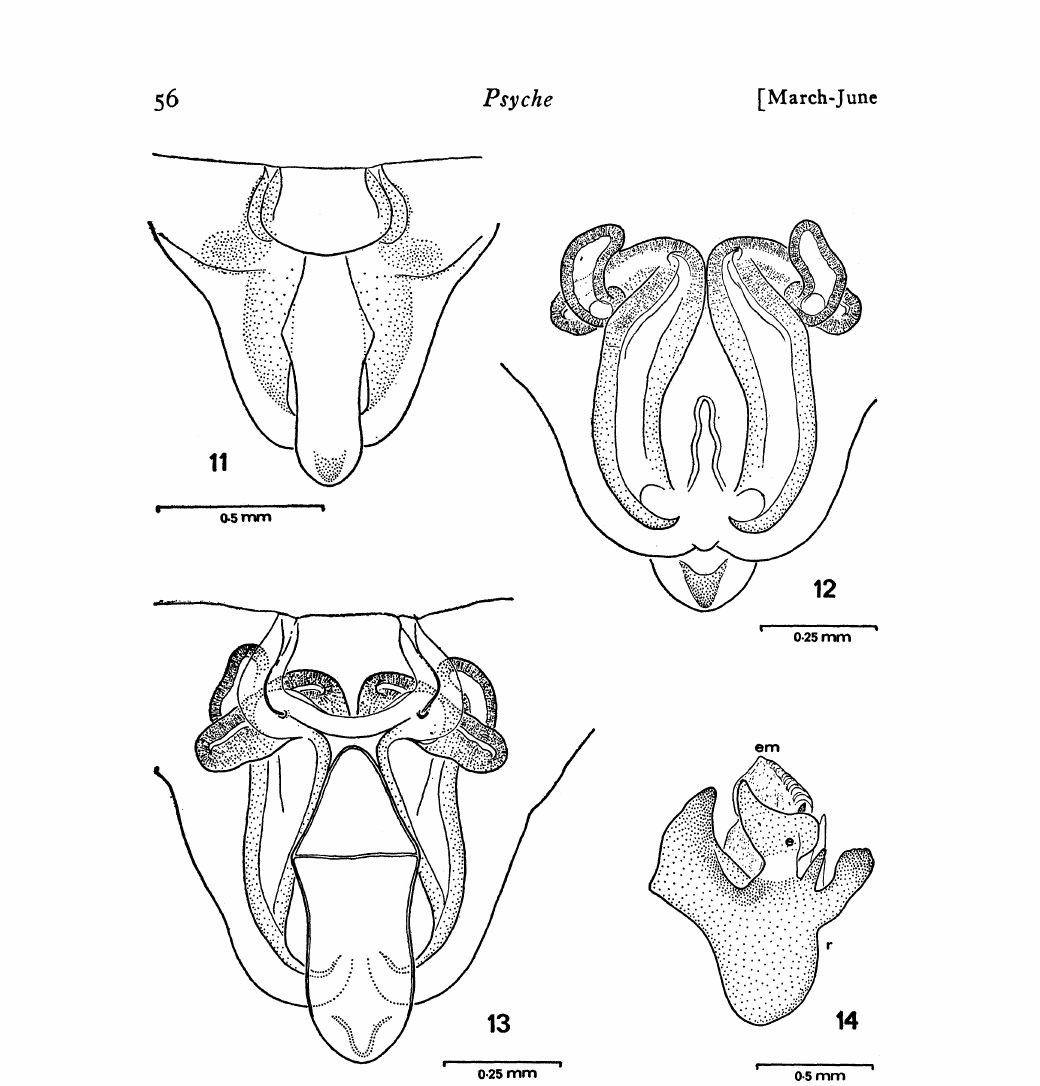
Figures 11-14. Oreonetides recuratus (Emerton). Fig. 11, epigyne, dor- sal aspect. Figs. 12-13, vulva, ventral (12) and dorsal (13) aspects. Fig. 14, radix (r), embolus (e) and embolic membrane (era) of male palp, mesal